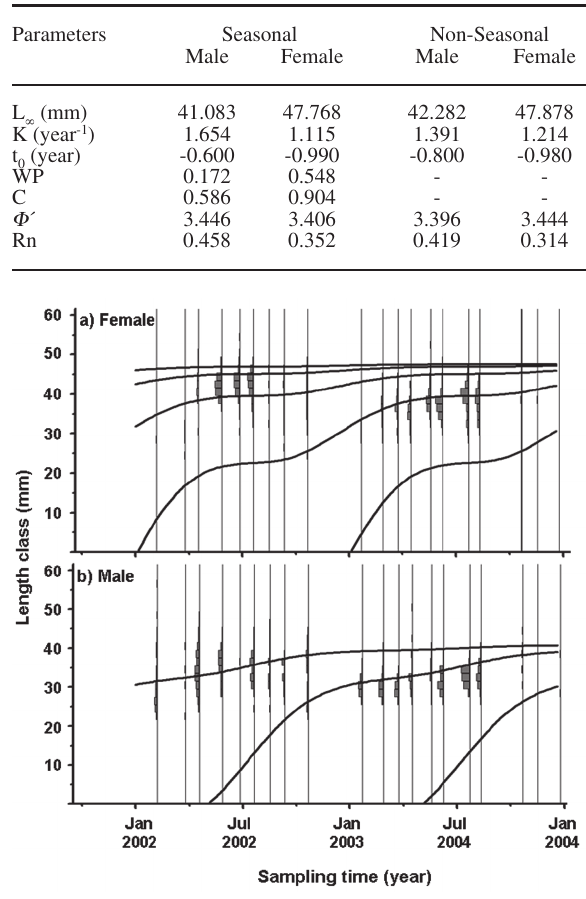
Fig . 3. – Length frequency distribution (bars) of females (a) and males (b) of Palaemon elegans with seasonal von Bertalanffy growth curves (lines) superimposed. The estimated seasonal von Bertalanffy growth parameters were L (mm) = 41.083, K (year -1 ) ∞ = 1.654, t (year) = -0.600, WP = 0.172, and C = 0.586 for males 0 and L (mm) = 47.768, K (year -1 ) = 1.115, t (year) = -0.990, WP = 0 ∞ 0.548, and C = 0.904 for